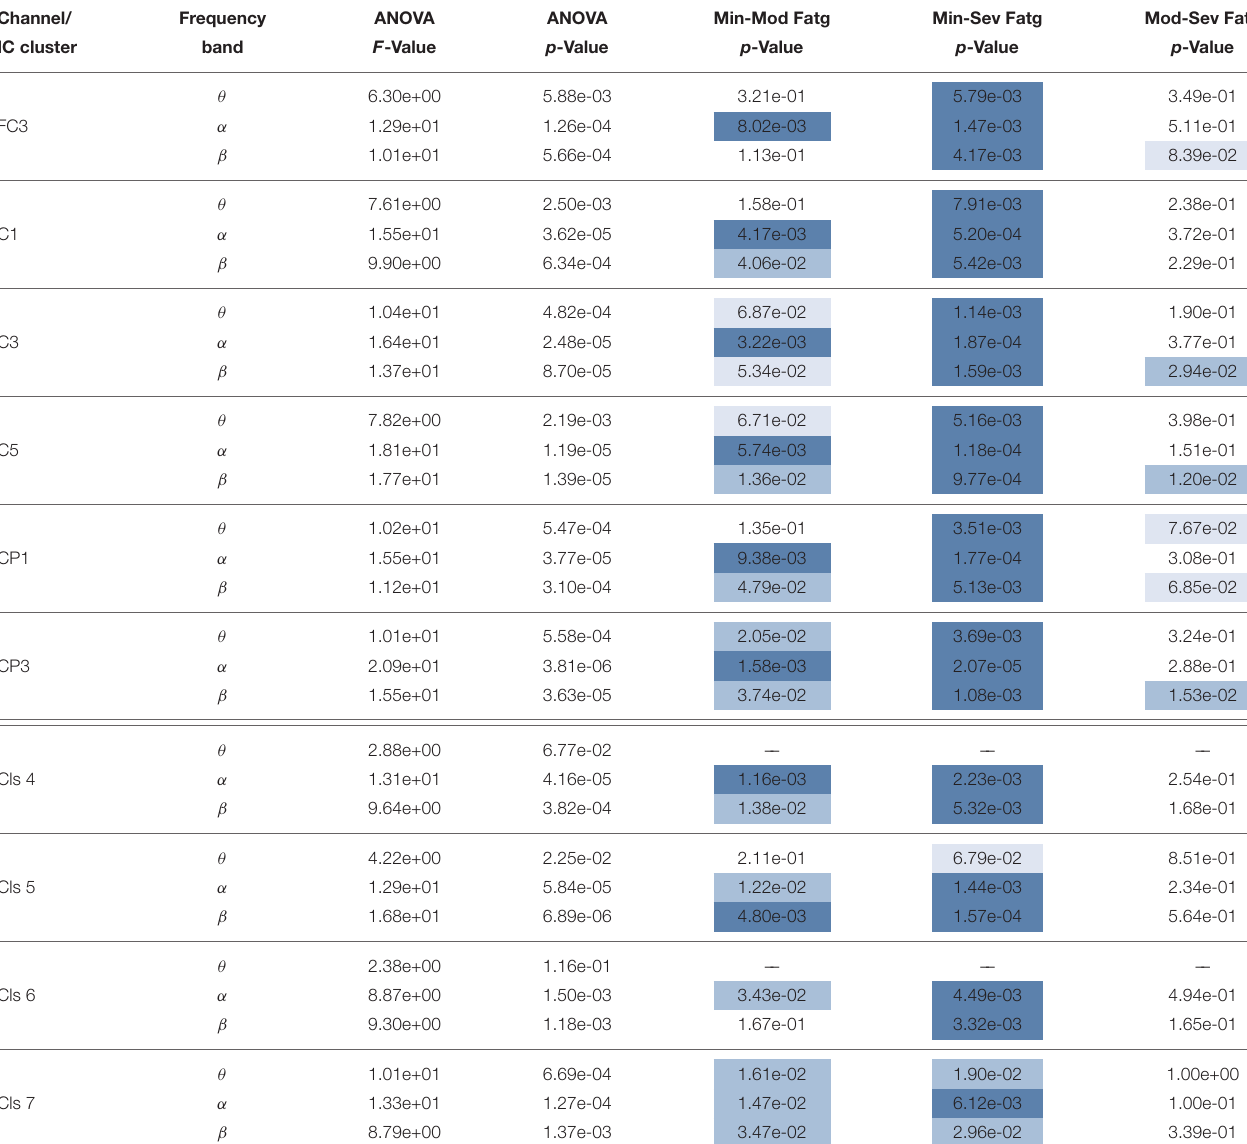
TABLE 2 | A one-way repeated measures ANOVA and the post-hoc analysis (if p < 0.05 from ANOVA) resulted in the following F - and p -values for the time-averaged FatgCond theta-, alpha-, and beta-band ≈ ERSP computed from the EEG signals and IC sources during